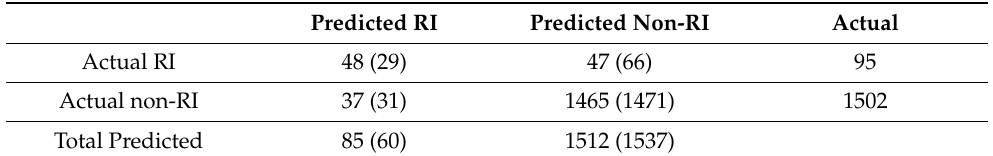
Table 3. Confusion matrix values after (before) hyperparameter tuning with the test data. The RI definition is the original definition by Kaplan and DeMaria (30 kt/day Vmax increase) [5]. Predicted RI Predicted Non-RI Actual Actual RI 48 (29) Actual non-RI 1512 (1537)